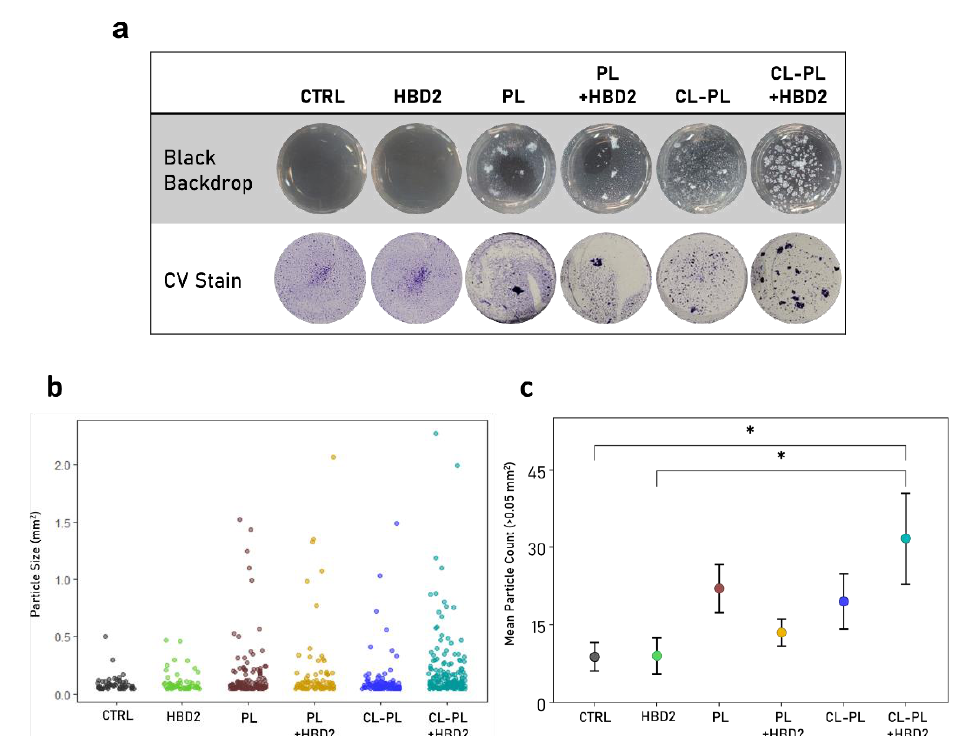
Figure 5. Biofilm structure of PA after treatment with HBD2 and liposomes. PA9027 was incubated for 18 h, with constant agitation, in the presence and absence of HBD2 and liposomes alone or combined in 24-well plates. CTRL: solvent control; PL: carrier liposomes; CL-PL: liposomes containing CL. HBD2 concentration was 0.25 µ M; CL concentration was 125 µ g/mL. ( a ) Representative images of PA9027 taken with a black backdrop before crystal violet staining (top), and after crystal violet staining, with a white backdrop. The latter images were further analyzed with ImageJ. ( b ) Distribution of stained biofilm particles over 0.05 mm 2 in size ( n = 101 for CTRL, n = 57 for HBD2, n = 133 for PL, n = 81 for PL + HBD2, n = 116 for CL-PL, and n = 182 for CL-PL + HBD2. ( c ) The number of particles above 0.05 mm 2 per well was determined and averaged. Shown are the means ± SEM from three independent experiments performed in duplicates. * indicates p < 0.05 in one-way ANOVA with Tukey’s post hoc adjustment.